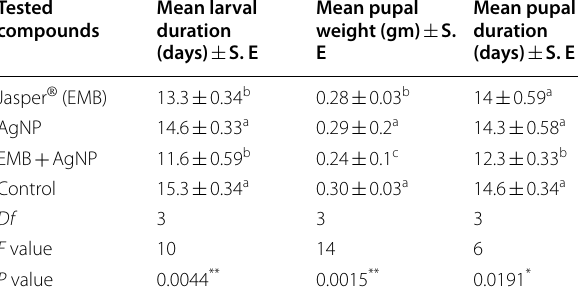
Table 2 Impact of the LC of the tested compounds on mean 50 larval duration, pupation rate, mean pupal weight, and mean pupal duration of the fourth instars larvae of S. littoralis Tested compounds